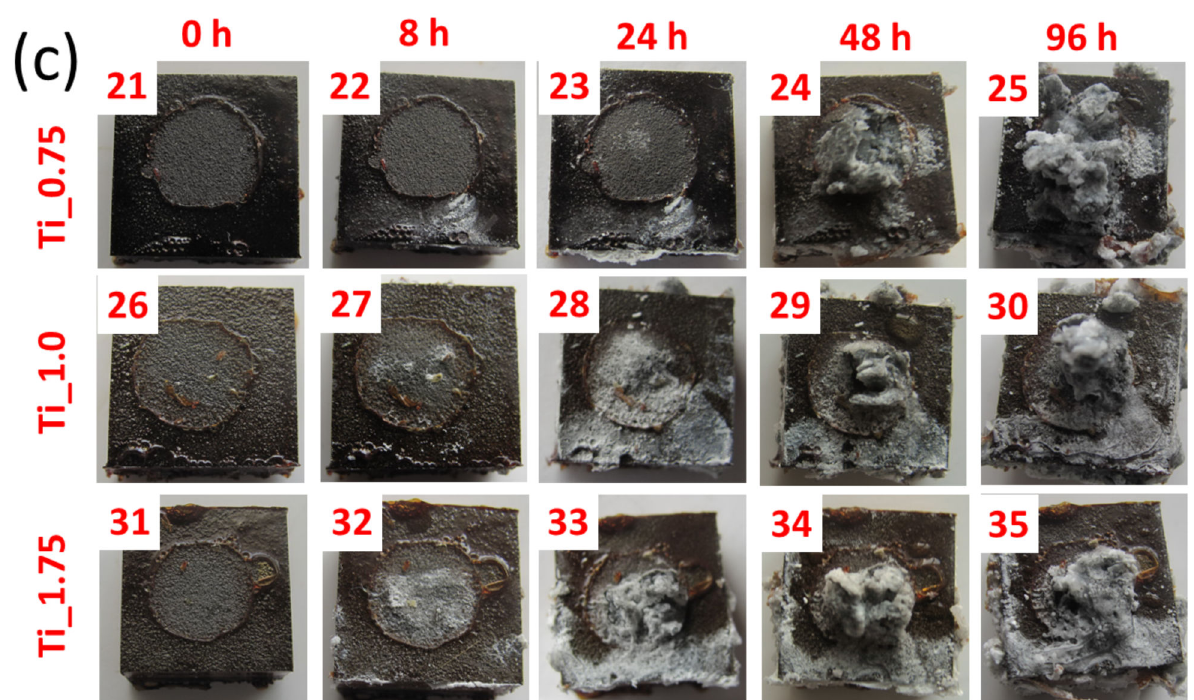
Figure 9. Surface observations at 0, 8, 24, 48, and 96 h of salt spray corrosion test for AZ91E substrate plate ( a ), WS Al ( b ) and Ti ( c )